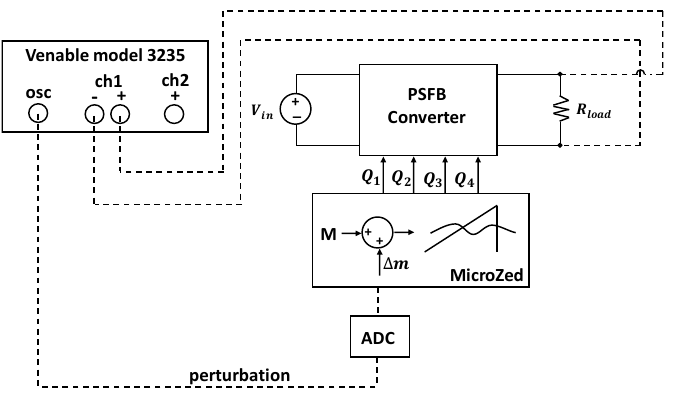
Figure 18. Measurement block diagram of G vvc ( s ) .